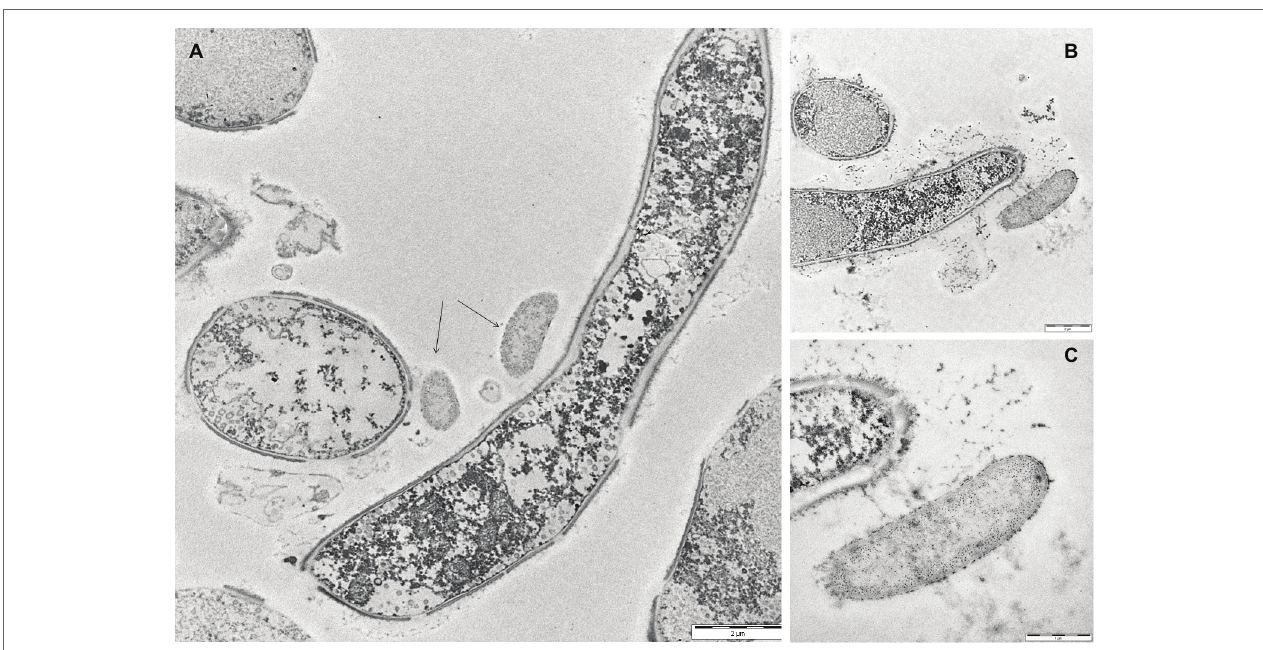
FIGURE 4 | Transmission electron micrographs of 24-h-old mixed P. ostreatus - P. alcaliphila biofilms. (A) Longitudinal and cross-view sections of P. ostreatus hyphae and adherent P. alcaliphila cells (see black arrows) (length of the bar: 2 μm). (B) The longitudinal section of the terminal portion of a P. ostreatus hypha with EPS-promoted attachment of a bacterial cell (length of the bar: 2 μm). (C) Magnification of (B) at the hyphal tip (length of the bar: 1